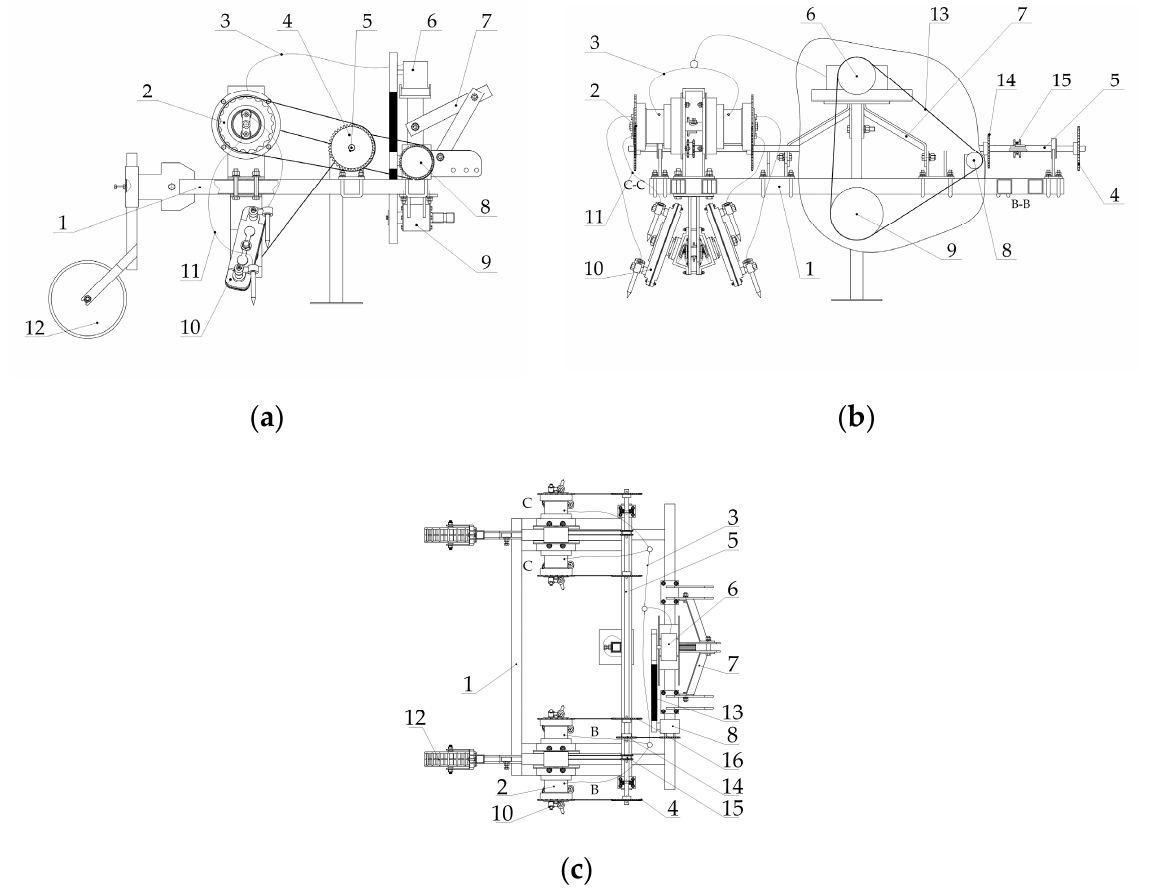
Figure 1. The deep ‐ hole liquid fertilizer applicator. ( a ) side view. ( b ) rear view. ( c ) top view. 1. frame assembly; 2. liquid fertilizer injecting control mechanism; 3. liquid fertilizer feeding main pipeline; 4. sprocket A; 5. main drive shaft; 6. liquid fertilizer pump; 7. three ‐ point suspension assembly; 8.